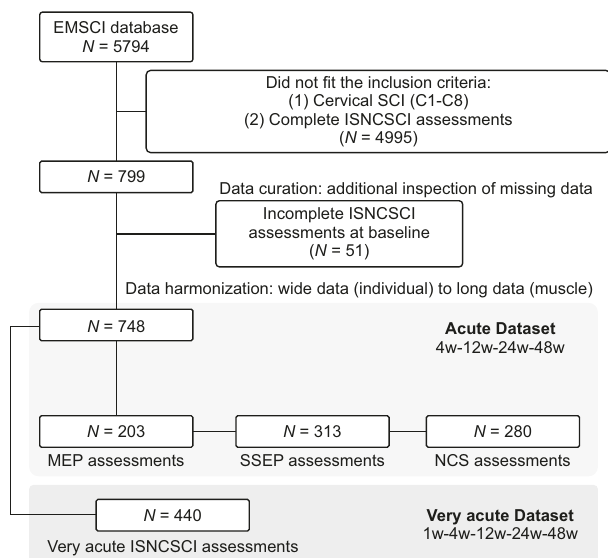
Fig. 1 | Participants included from the EMSCI Dataset. EMSCI=European Multi- Center Study about Spinal Cord Injury, ISNCSCI=International Standards for Neurological Classi fi cation of Spinal Cord Injury, SCI=Spinal Cord Injury, w= Week, MEP=Motor Evoked Potential, SSEP=Somatosensory Evoked Potential, NCS=Nerve Conduction